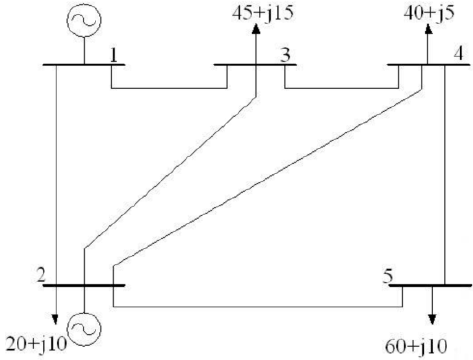
Figure 6. Single line diagram of the 5 bus IEEE network.